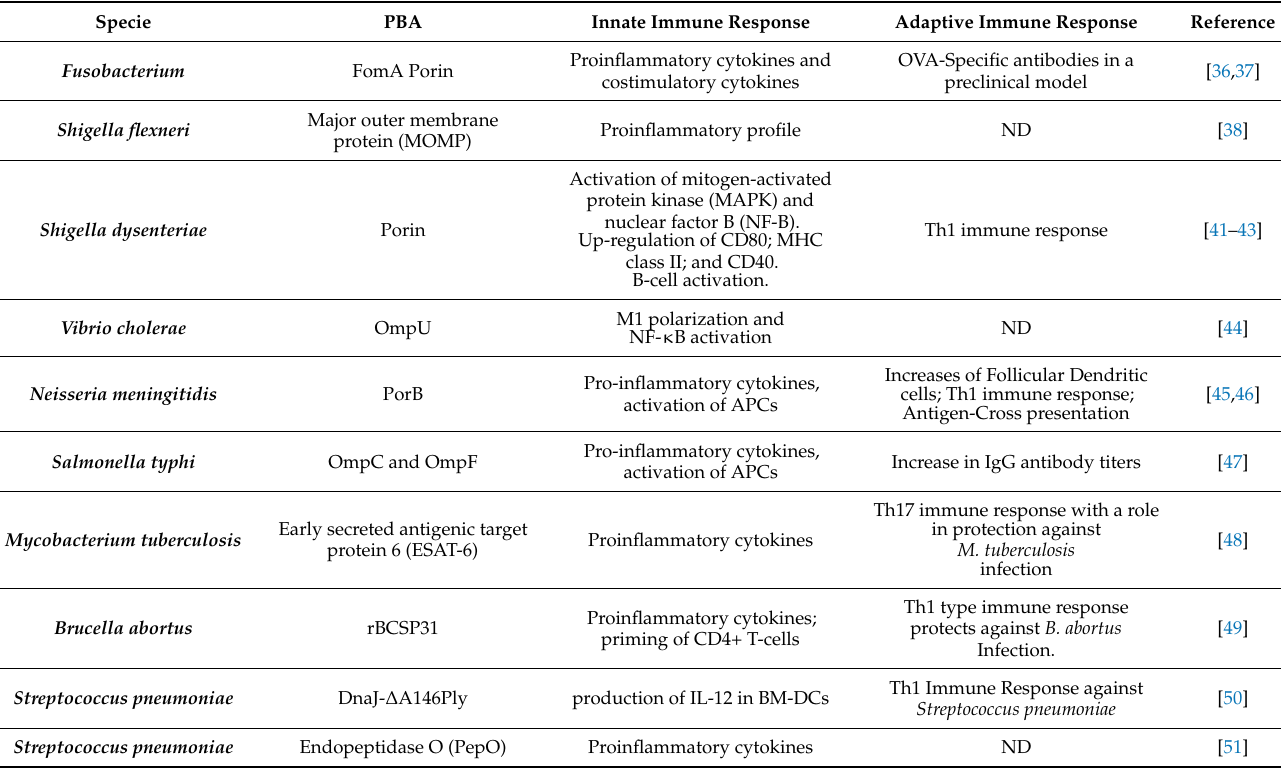
Table 1. Bacterial PBAs with TLR2 adjuvant